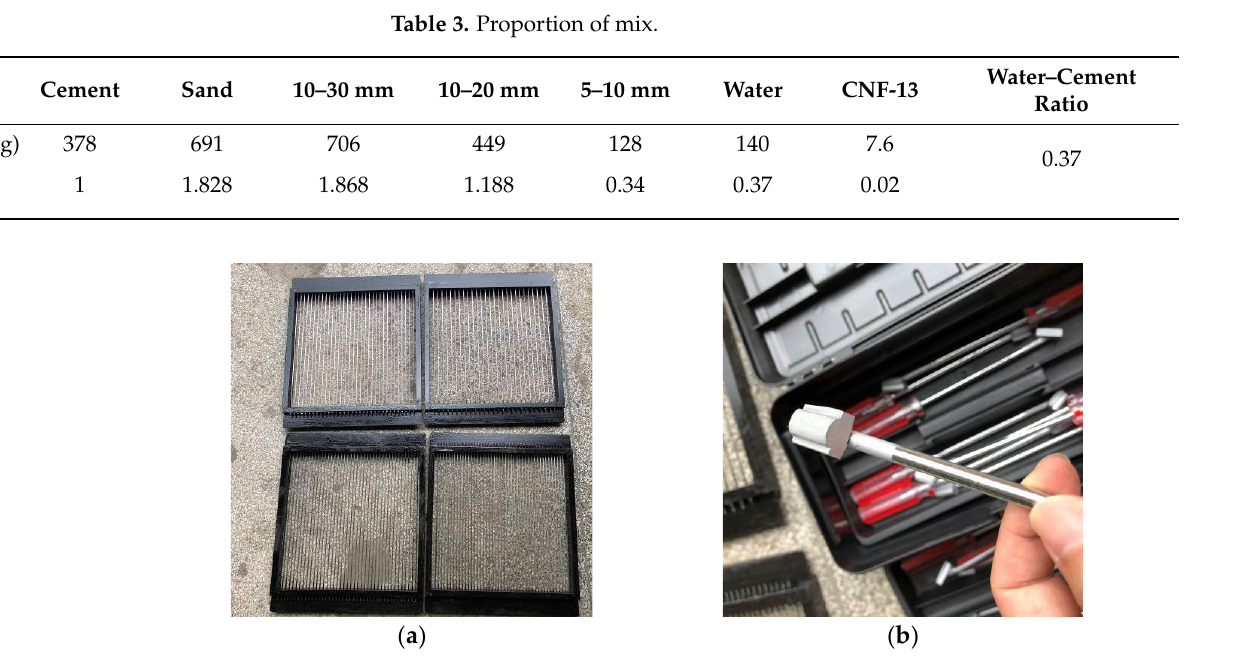
Figure 8. Tester for preparing samples: ( a ) rail mold; ( b ) texturing tool. Table 4. Factors and levels of the orthogonal